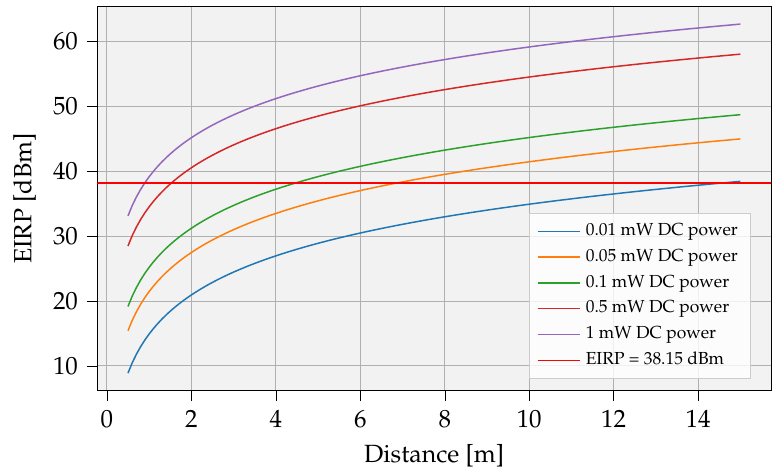
Figure 8. Required transmit power for an RF SISO system, expressed in EIRP.